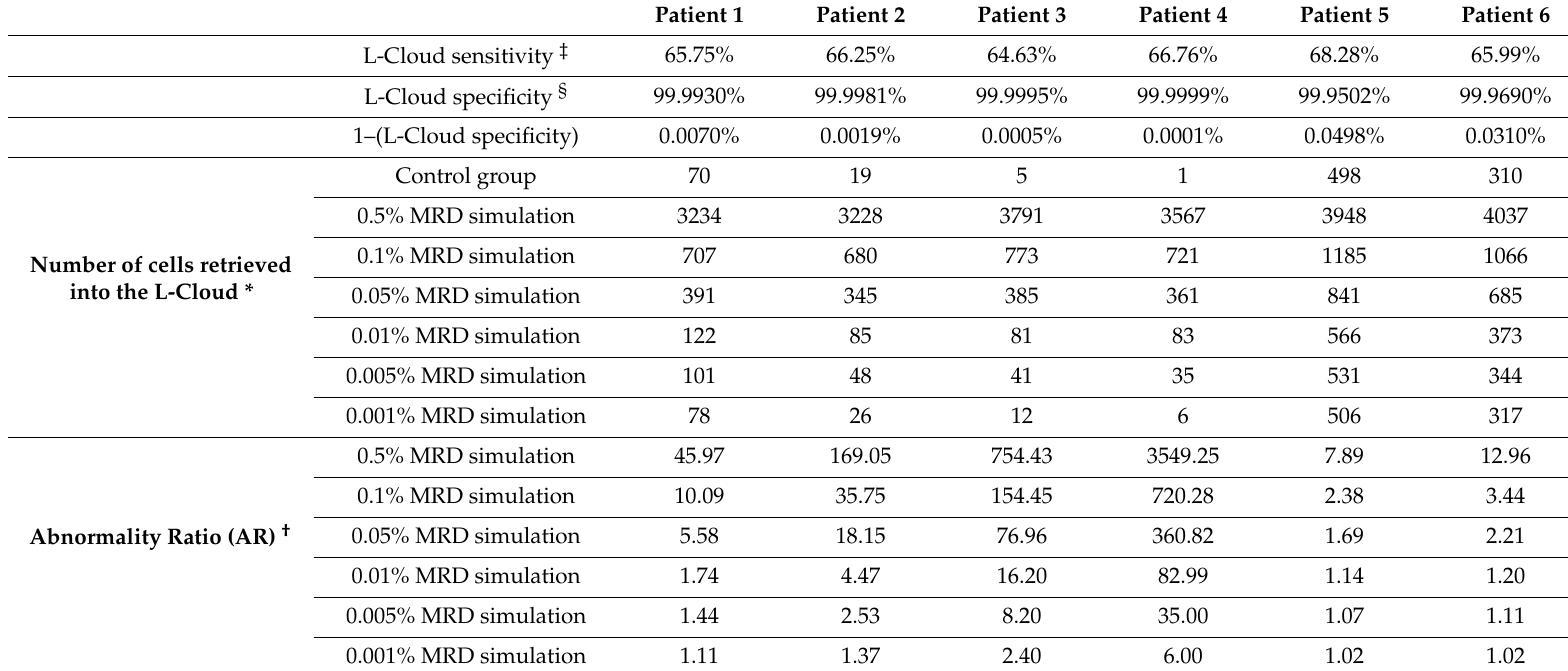
* The L-Cloud represents a model describing a multidimensional space where malignant cells are found. This region is patient-specific and is established following a well-defined algorithm at diagnosis (see Section 2.2). † The AR is a calculated parameter obtained by following formula: AR = ((L-Cloud cells per total cells) of simulated sample) / ((L-Cloud cells per total cells) of control group sample). ‡ The L-Cloud sensitivity is defined by the number of cells from the “L-Cloud cell cluster” falling into the L-Cloud divided by the number of cells contained into this same cluster ( = 10 4 cells) as a percentage. § The L-Cloud specificity is defined by the number of cells of the control group falling outside the L-Cloud divided by the number of cells of the control group analyzed ( = 10 6 cells) as a